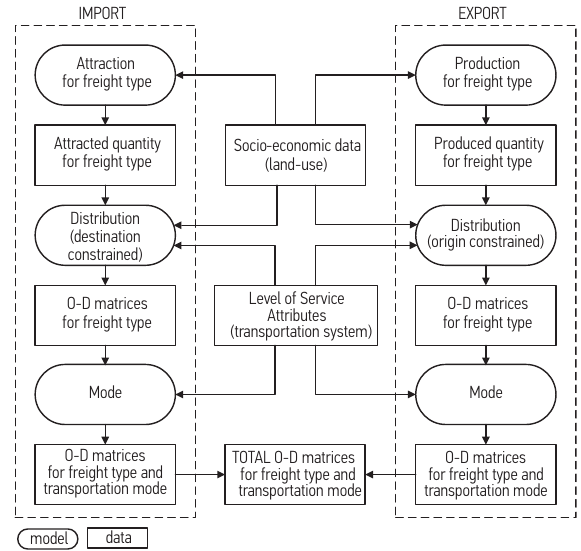
Fig. 1. The proposed modelling